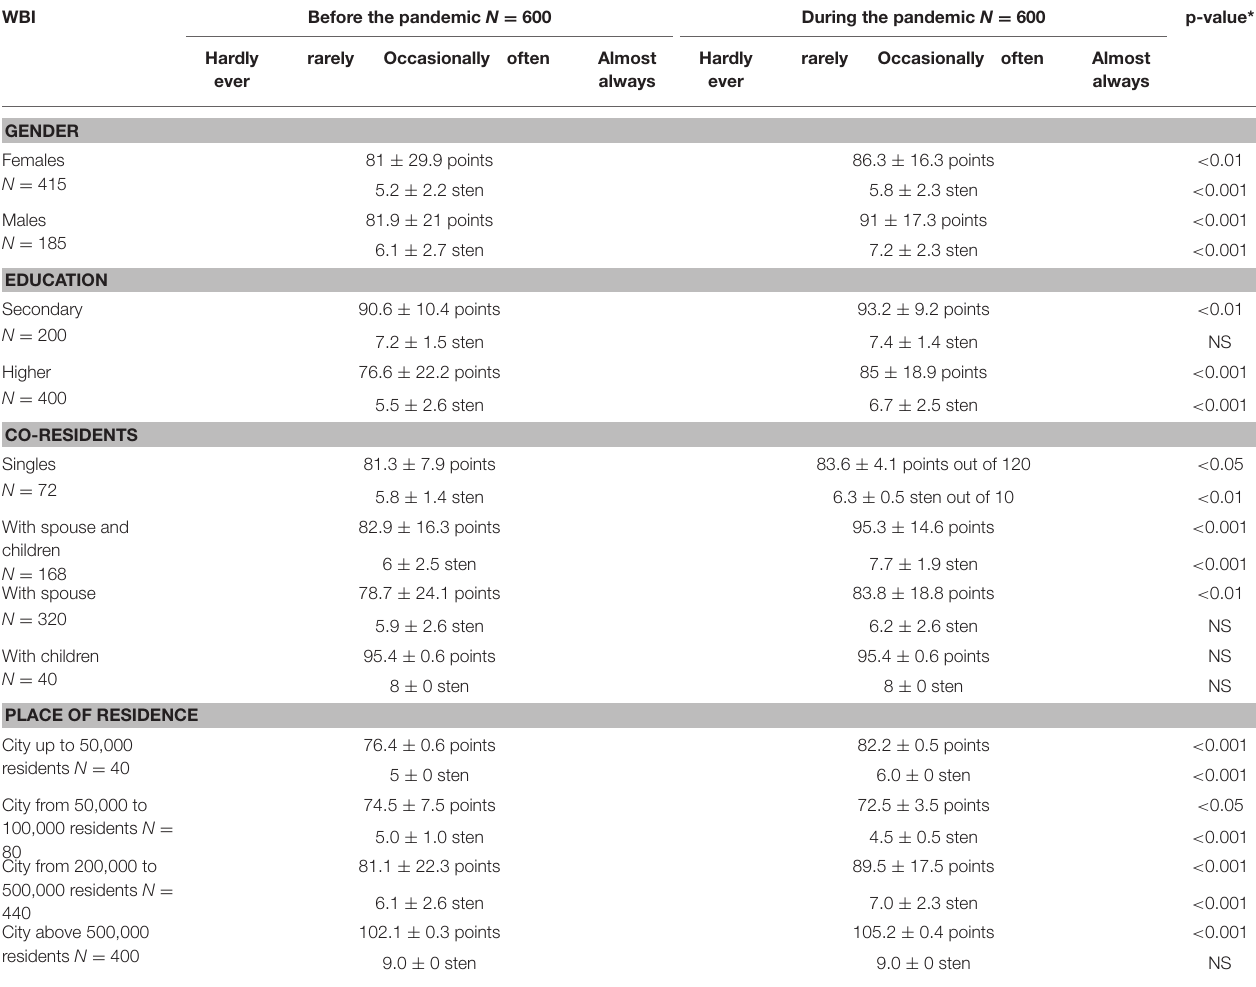
TABLE 5 | Rates of health-related behaviors before and during the pandemic by gender, education, co-residents, and place of residence. WBI Before the pandemic N = 600 During the pandemic N = 600 p-value* Hardly rarely Occasionally often Almost Hardly rarely Occasionally often Almost ever always ever